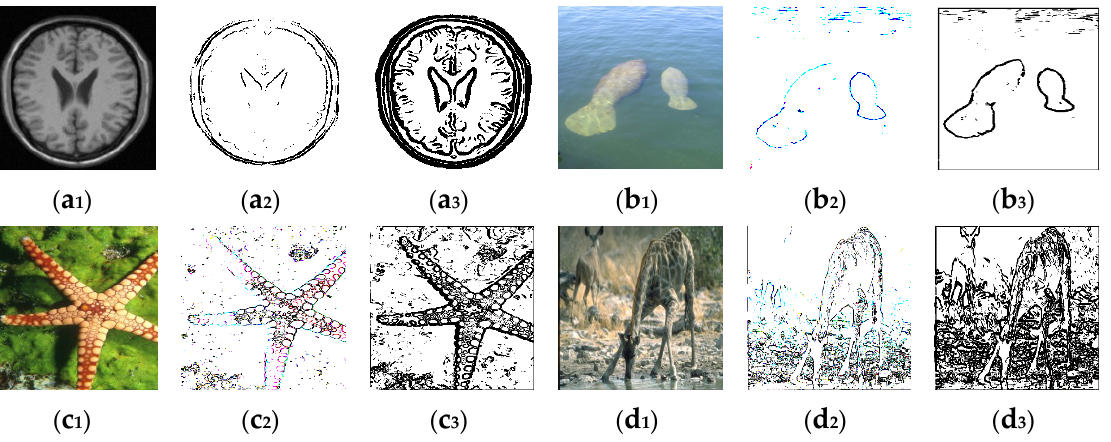
Figure 2. Results of gradient comparison of different images: ( a 1 -d 1 ) are the original images selected for the experiment; ( a 2 -d 2 ) are the integer-order gradient maps corresponding to the original im- ages; ( a 3 -d 3 ) are the fractional-order gradient maps corresponding to the original images.